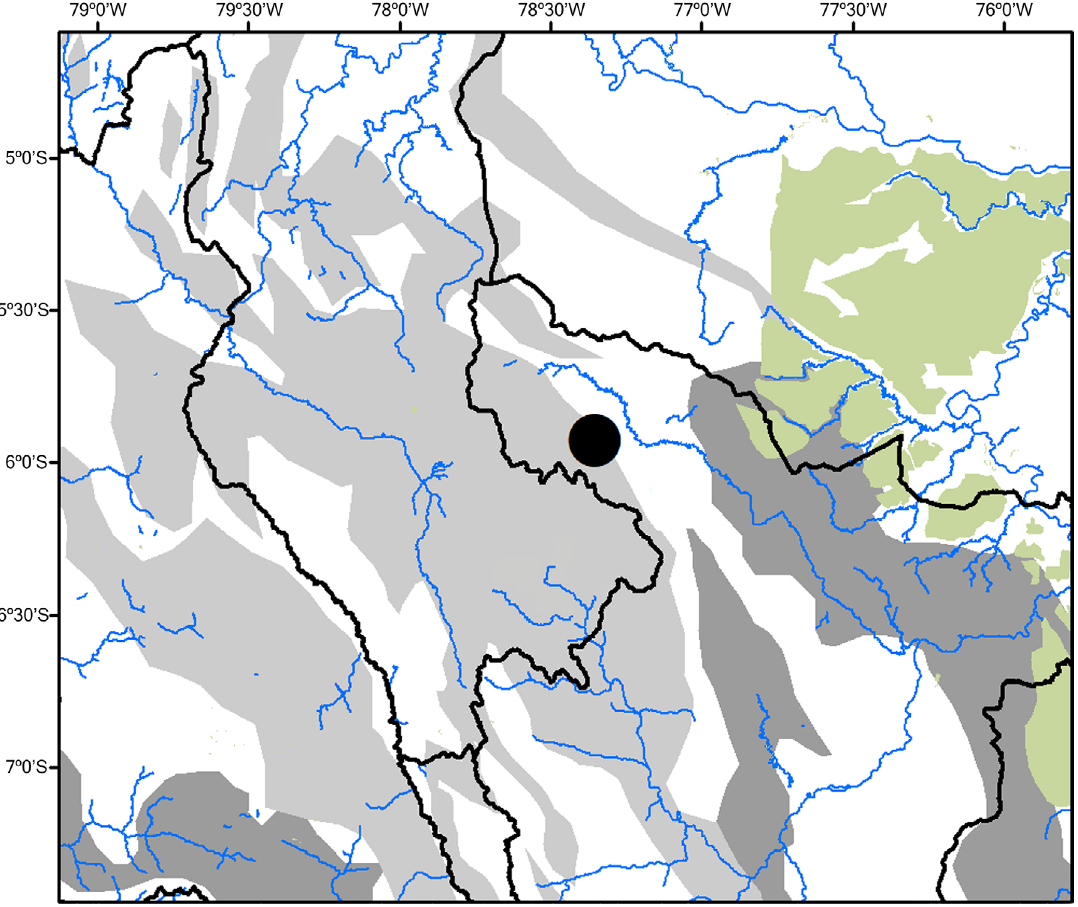
Figure 1. Map of the type locality of Caecopactes chullachaqui Campos-Filho, Sfenthourakis and Bichuette sp. nov. ● Cueva de Palestina. Green areas: legal conservation units; dark grey: discontinuous carbonate rocks; light gray: continuous carbonate